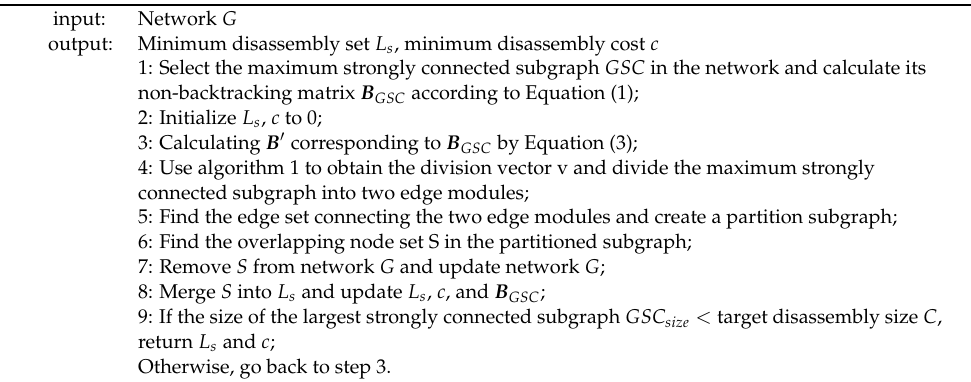
Algorithm 2: Directed network disassembly algorithm (DIR